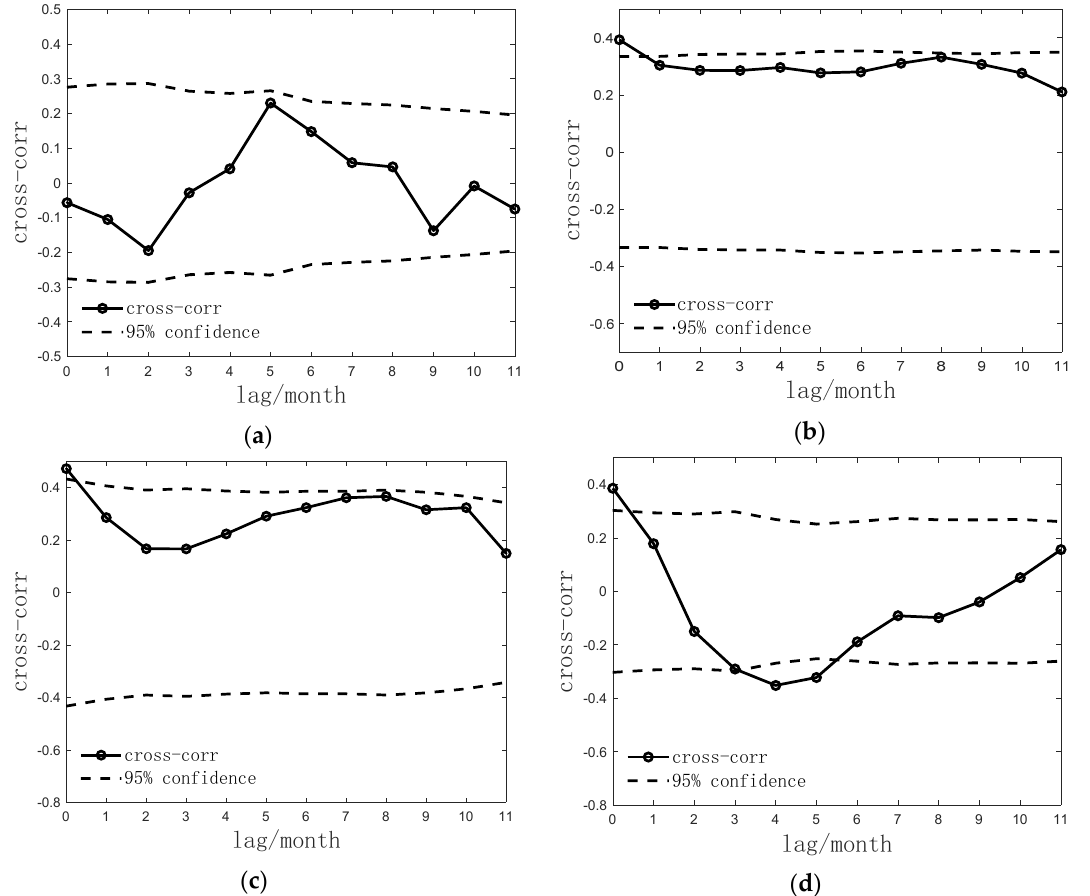
Figure 7. Correlation test between monthly frequency of seismicity and reservoir water level in the study area during the impoundment of the Three Gorges Project (January 2001–December 2009) . ( a ) Before the impoundment; ( b ) 135 m stage; ( c ) 156 m stage; ( d ) 175 m stage.